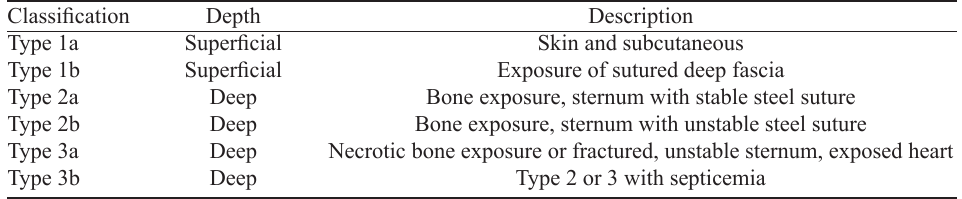
Table 3. Classification proposed by Jones in 1997 based on anatomical site plus a type including